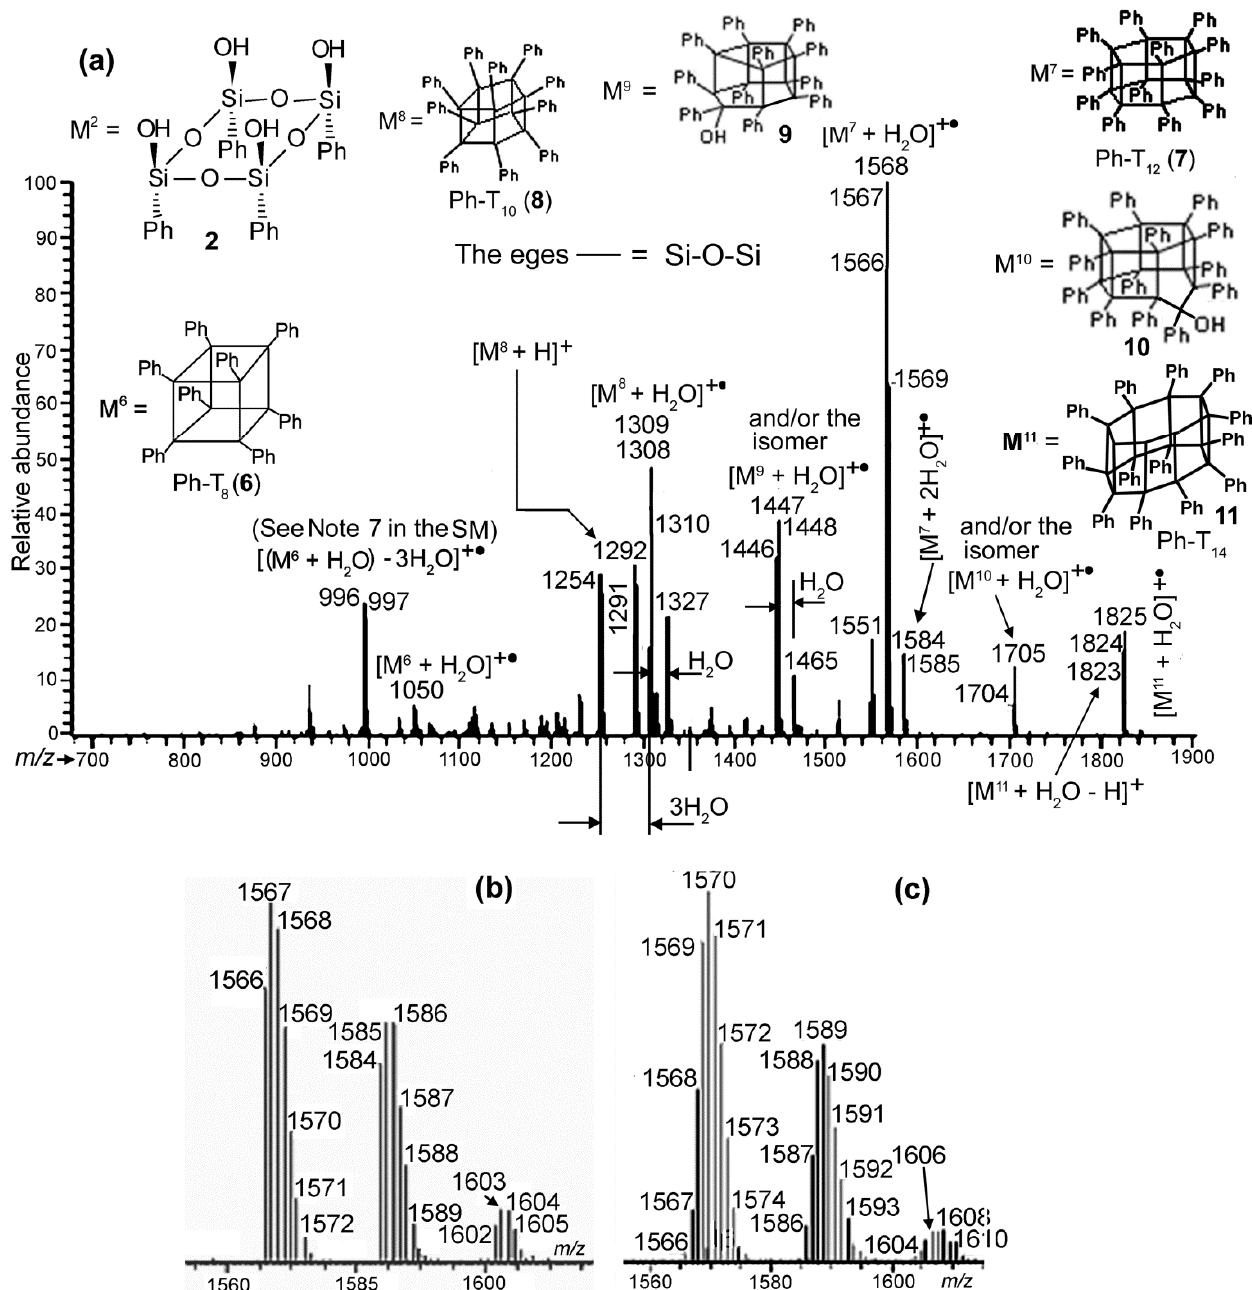
Figure 7. ( a ) PI APCI mass spectrum of the precipitate from the reaction mixture of the self-condensation of compound 2 carried out in a quartz flask in toluene at 110 °C for 120 min, ( b , c )—The m/z 1555–1615 segments of the spectra recorded when H 2 O and D 2 O were simultaneously syringed into the mass spectrometer, respectively.